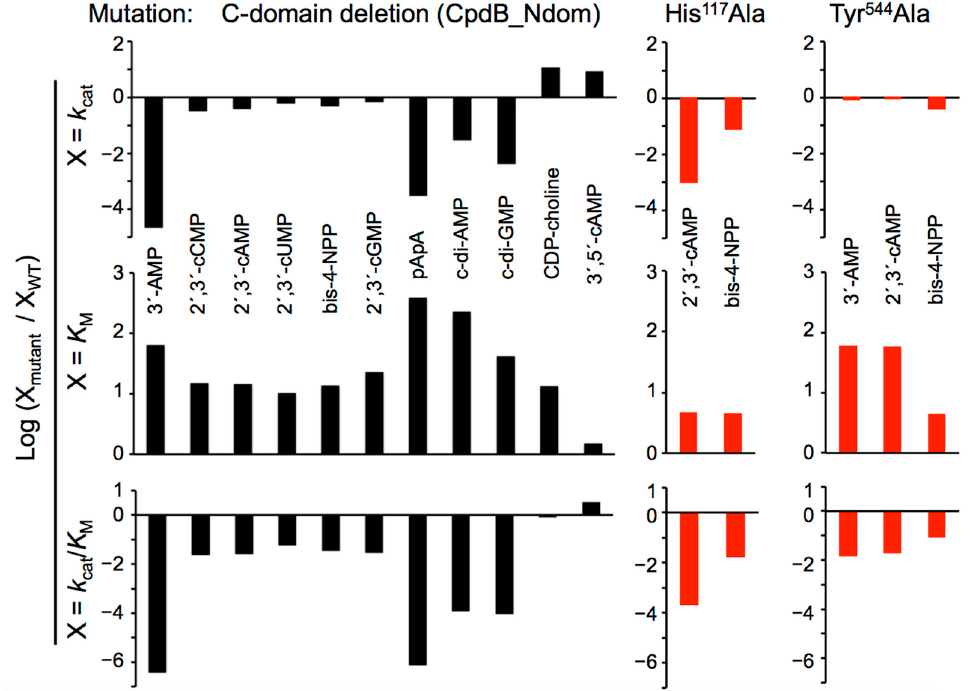
Figure 2. Effect of mutations on the kinetic parameters of CpdB. The mean values of the catalytic parameters of Table 1 were divided by the corresponding values of wild-type CpdB as determined in earlier work [4] and shown also in Table 1. Substrates giving insignificant rates with the point mutants (see footnotes 2 and 3 in Table 1) cannot be plotted here as in the absence of significant rates, kinetic parameters cannot be estimated.